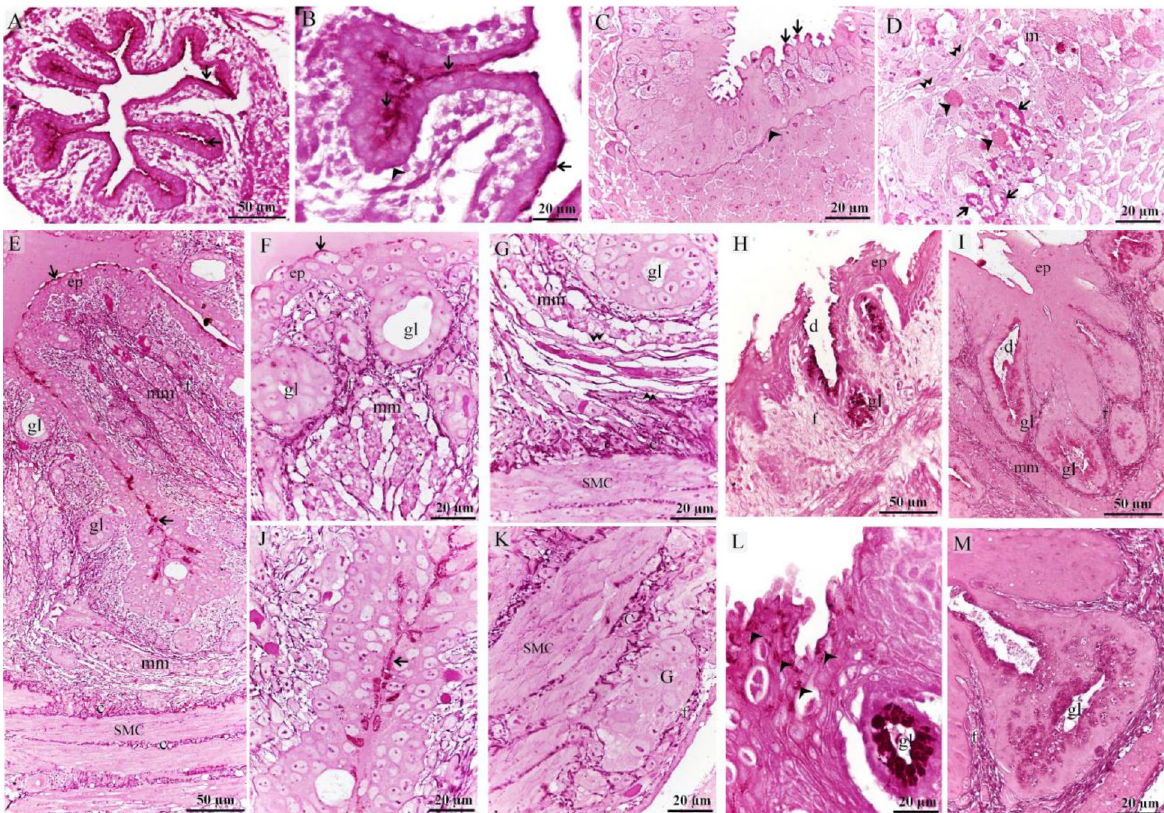
Figure 6. Staining affinity of the day 8, 13, 15 esophagus for PAS. Paraffin ( A , B , E , J ) and semi-thin ( C , D , F – I , K – M ) sections of day 8 ( A – D ), 13 ( E – G , J , K ) and 15 ( H , I , L , M ) stained with PAS. ( A – C ) epithelium had PAS- positive granules (arrows). basal lamina (arrowheads). ( D ) The developing muscular layer was distinguished by the myoblasts (m). note PAS-positive glycogen granules (arrowheads), PAS-positive myelin sheath (arrows). Telocytes (double arrowheads) located around the developing muscular layer. ( E – G , J , K ) The esophagus was lined by pseudostratified epithelium which exhibited PAS-positive reaction at the apical surface (arrows). The gland (gl) was inactive PAS-ve. Note PAS-positive Reticular fibers (f). muscularis mucosae (mm). muscular layer (SMC). parasympathetic ganglion (G), Telocytes (double arrowheads). ( H , I , L , M ) The esophagus was lined by stratified squamous epithelium (ep) and developed active mucus glands (gl) that exhibited PAS-positive granules. The duct (d) was lined by mucous-secreting cells (arrowheads). Note PAS-positive Reticular fibers (f). muscularis mucosae